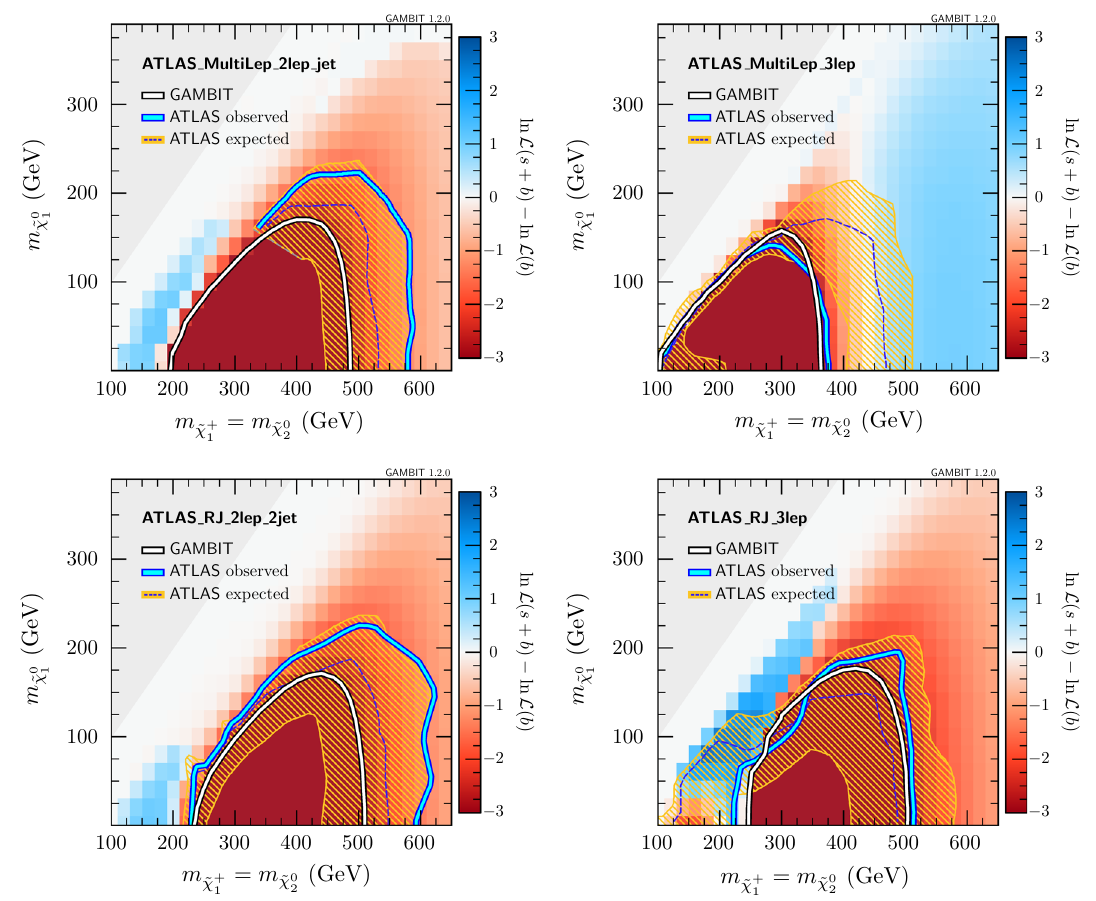
Fig. 2 GAMBIT reproductions of 95% CL ATLAS exclusion limits for a simplified model of wino production. The results for the “con- ventional” multilepton analysis [116] and the recursive jigsaw analysis [117] are shown in the top and bottom rows, respectively. In both cases results are given separately for 2-lepton (left) and 3-lepton (right) signal regions. The ATLAS observed (light blue) and expected (dashed, dark